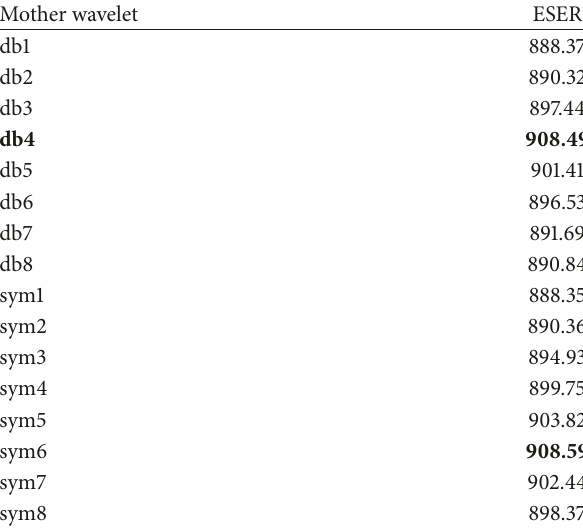
Table 1: The average WSER of the mother wavelets.